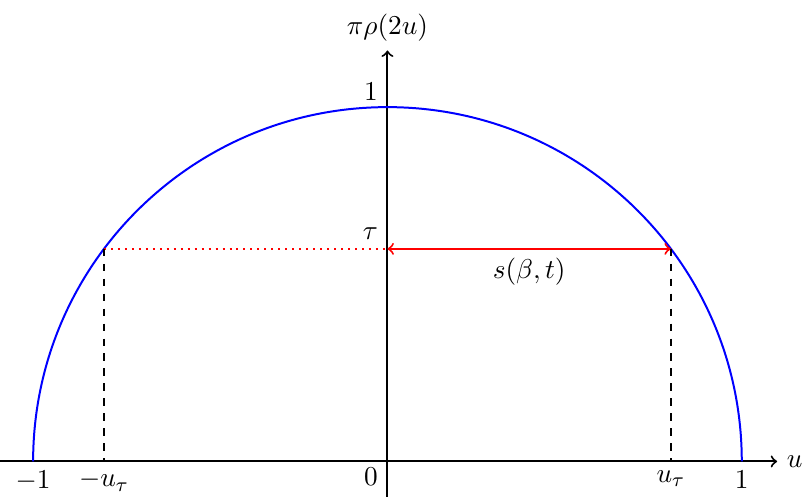
p 1 (cid:0) u 2 . The time slice (cid:25)(cid:26) (2 u ) = (cid:28) is